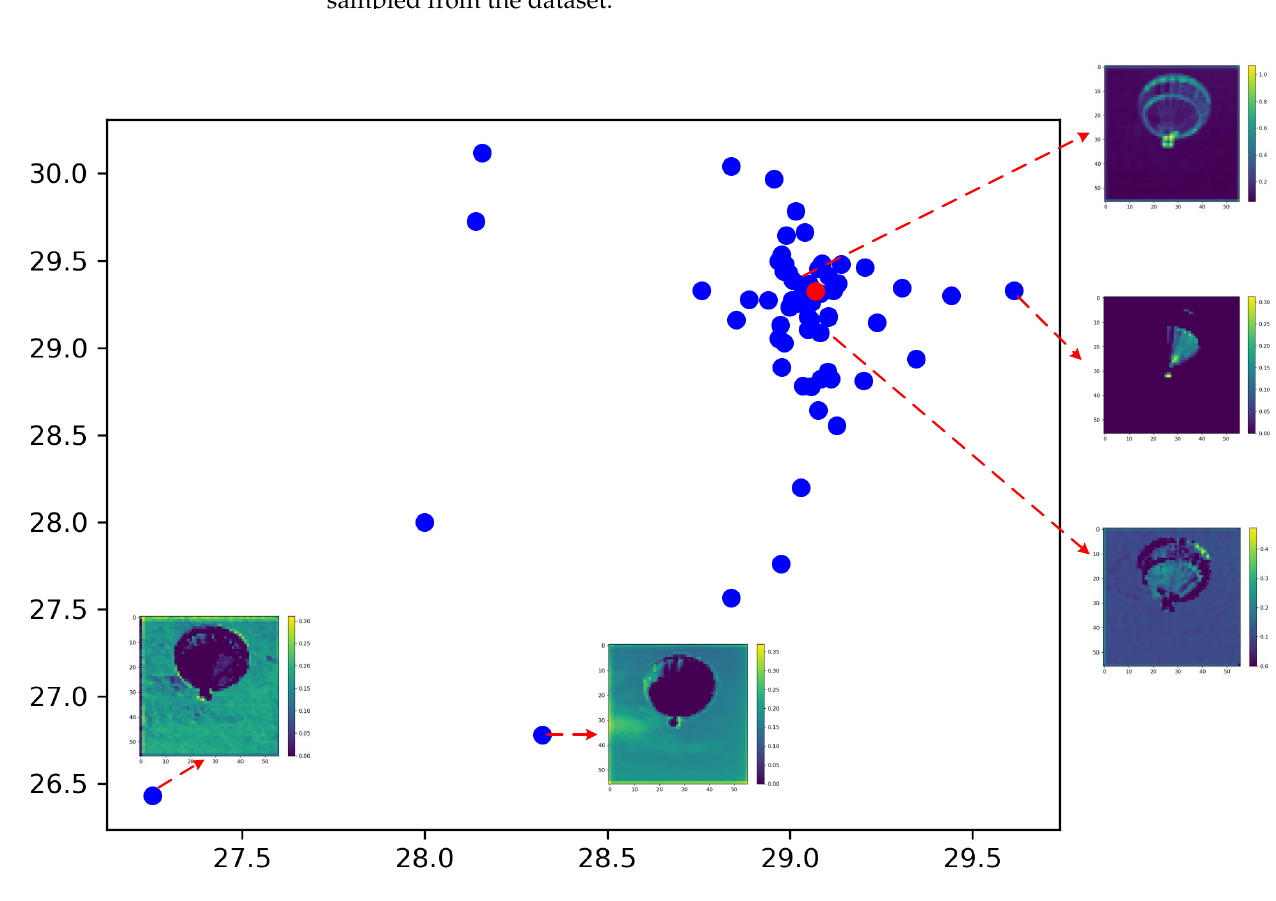
Figure 3. The centroid distribution of the feature maps.